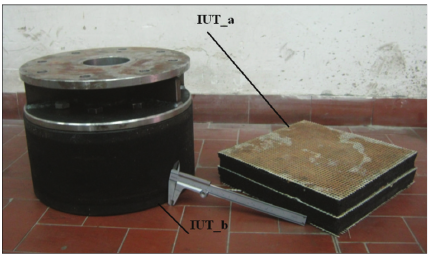
Figure 9: Seismic isolators presented in